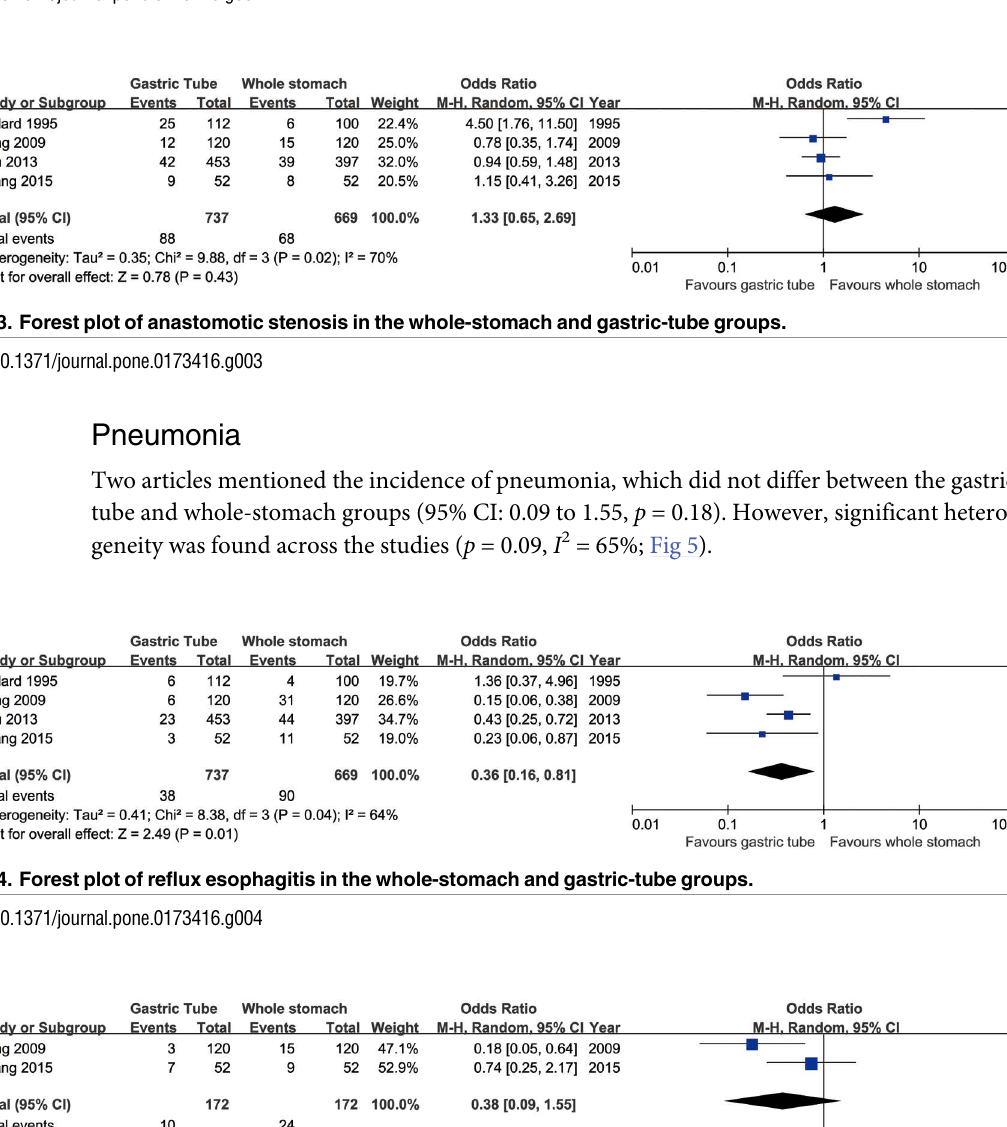
Fig 2. Forest plot of anastomotic leakage in the whole-stomach and gastric-tube groups.